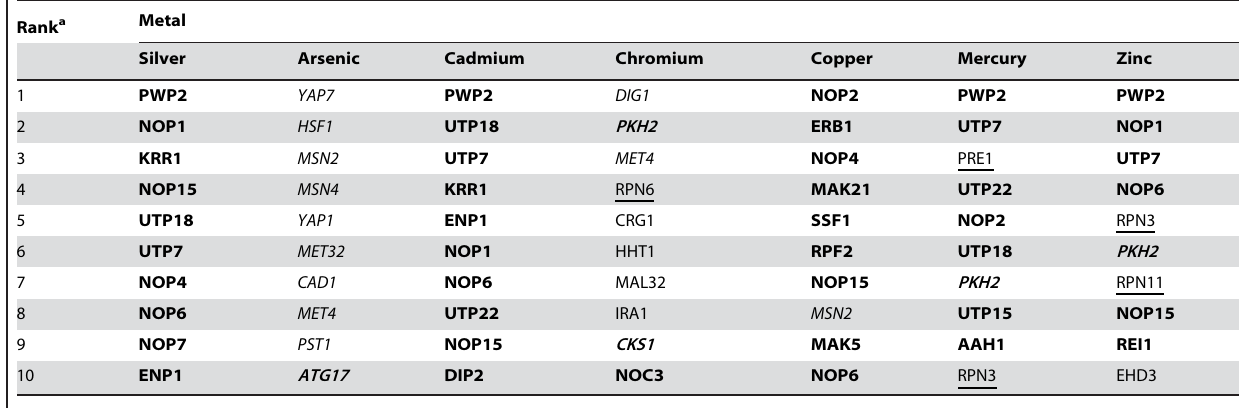
Table 2. Ten Most Significant Interacting